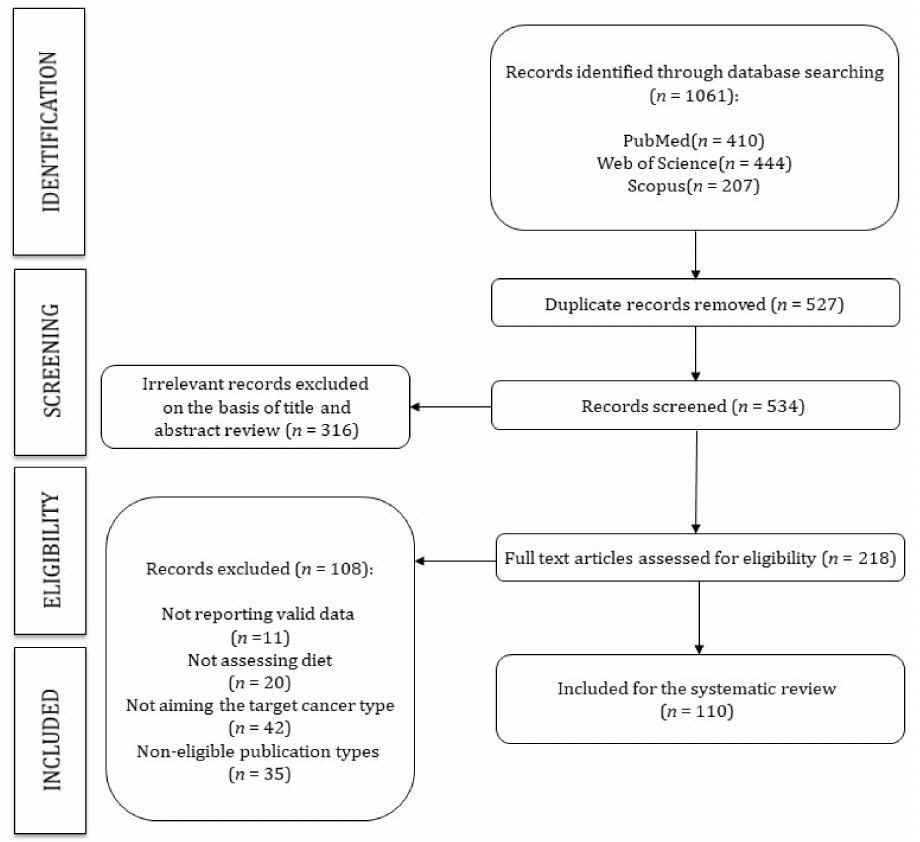
Figure 1. Preferred Reporting Items for Systematic Reviews and Meta-Analyses (PRISMA) flow diagram of study selection, inclusion and